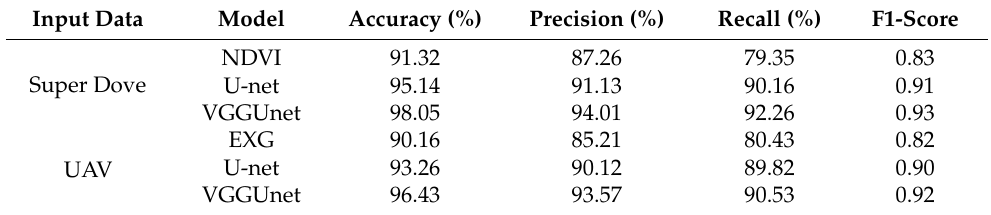
Table 3. The accuracy of Ulva prolifera ( U. prolifera ) extraction on Super Dove and unmanned aerial vehicle (UAV) images using different